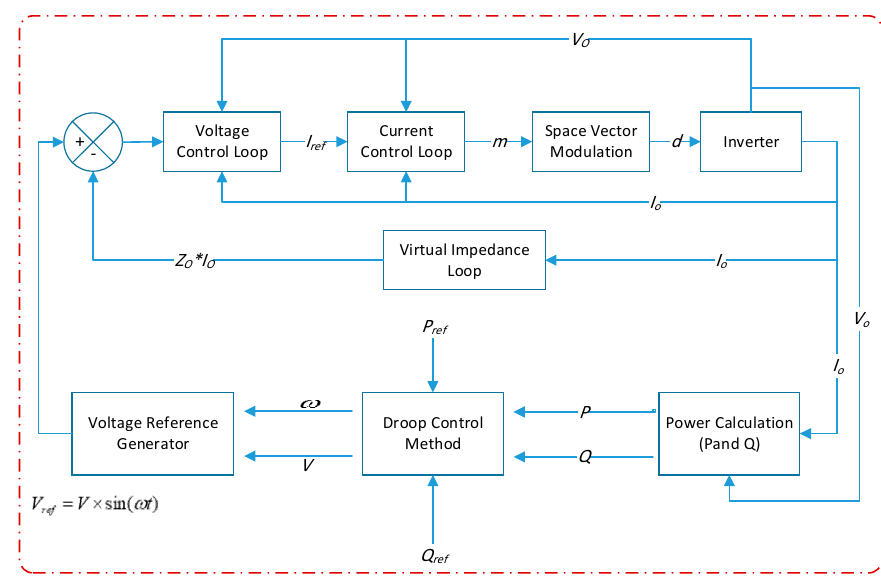
Figure 2. Droop control structure.